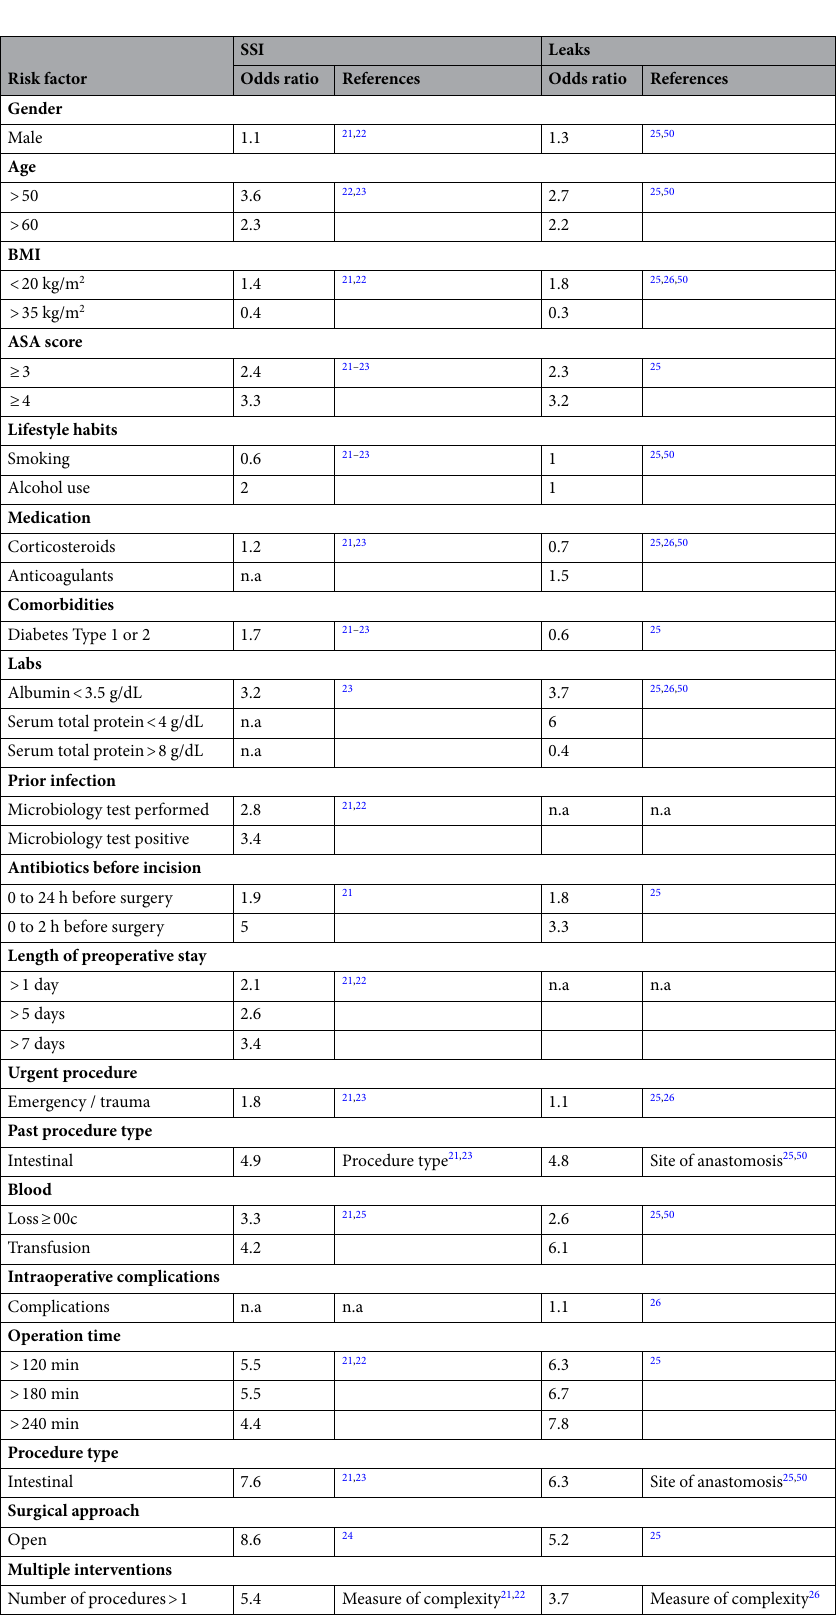
Table 2. Risk factors, odds ratios and literature references for SSI and leaks. Table shows risk factor for SSI and leaks identified based on a selective literature search together with their associated odds ratios calculated on the data set. Past procedure type was added as a preoperative indicator for the performed surgery as procedure type was only available postoperatively. n.a. (not applicable), the feature has not been identified as a risk